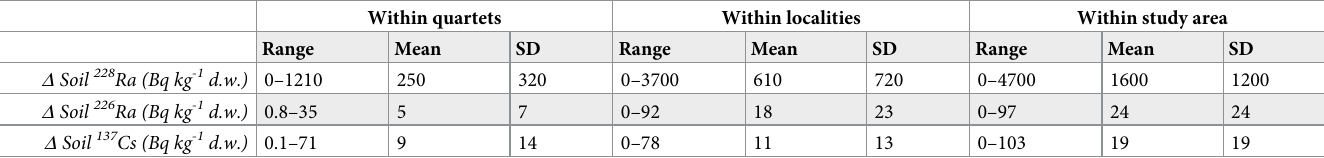
Table 2. Spatial heterogeneity.